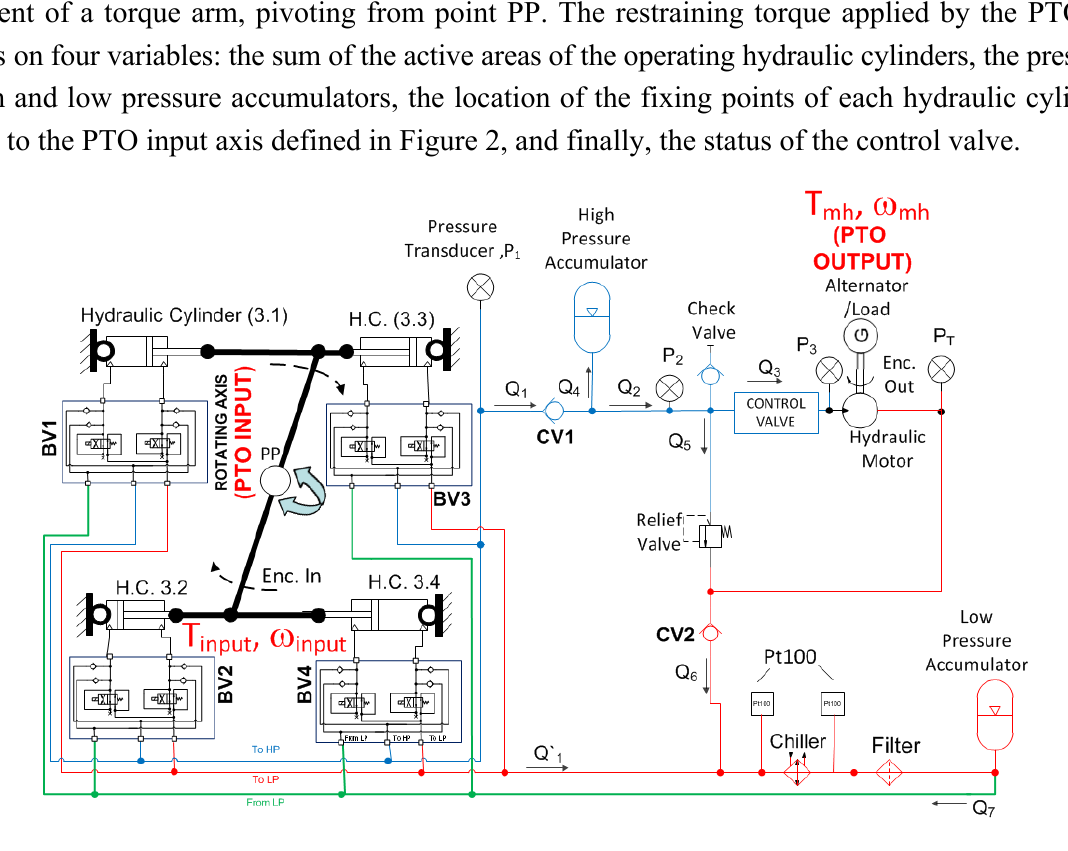
Figure 1. PTO Hydraulic